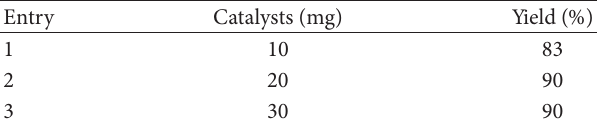
T 4: Optimization of reaction conditions a